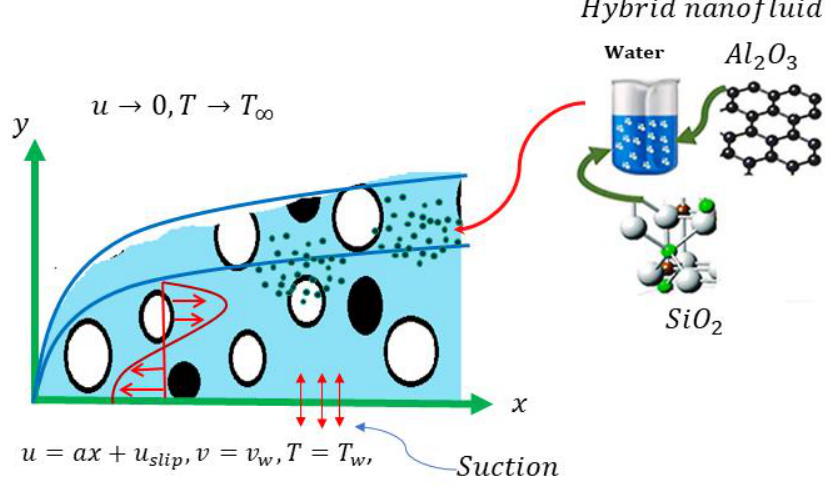
Figure 1. The present problem configuration.